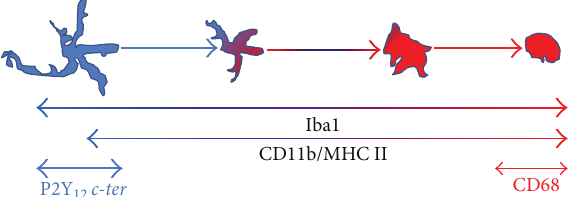
Figure 7: Draw of microglial marker expression as a function of activation . Branched microglia are represented in blue and activated microglia in red. Iba1 [22], CD11b, and MHC II are mostly expressed in microglia throughout the different morphological states and their expression increases during activation (light blue to red color). P2Y 12 c-ter (light blue) and CD68 (red) are expressed, respectively, in branched or roundish/activated